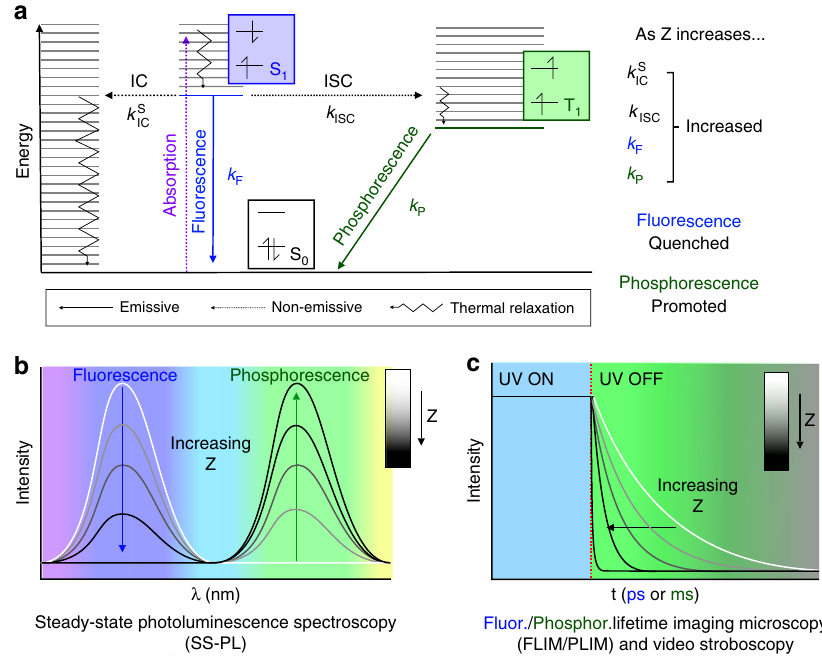
Fig. 5 The mechanism for PL behaviour modi fi cation in carbon nanodot (CND)/host nanocomposites. Modi fi ed Jablonski diagram indicating electronic states (S 0 (black), S 1 (blue), and T 1 (green) and their relative energy levels; electronic transitions (non-emissive absorption (dotted purple), intersystem crossed (ISC, dotted black), internal conversion (IC, dotted black), and thermal relaxations (jagged black); and emissive fl uorescence (solid blue) and phosphorescence (solid green)) and associated rate constants; and electronic spin states ( a ). The effect of increasing Z on rate constants is summarised in a . The implications of increasing Z on fl uorescence and phosphorescence intensities ( b ) and lifetimes ( c ) are summarised with photoluminescent (PL) spectra ( b ) and decay curves ( c ). PL spectra and decay curves are given in greyscale, from low Z (white) to high Z